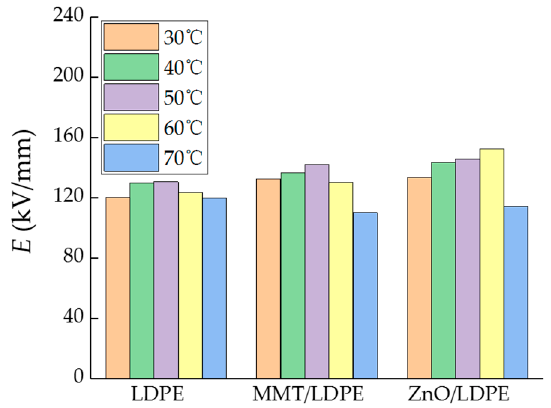
Figure 9. The temperature curves of Weibull parameters in different materials.